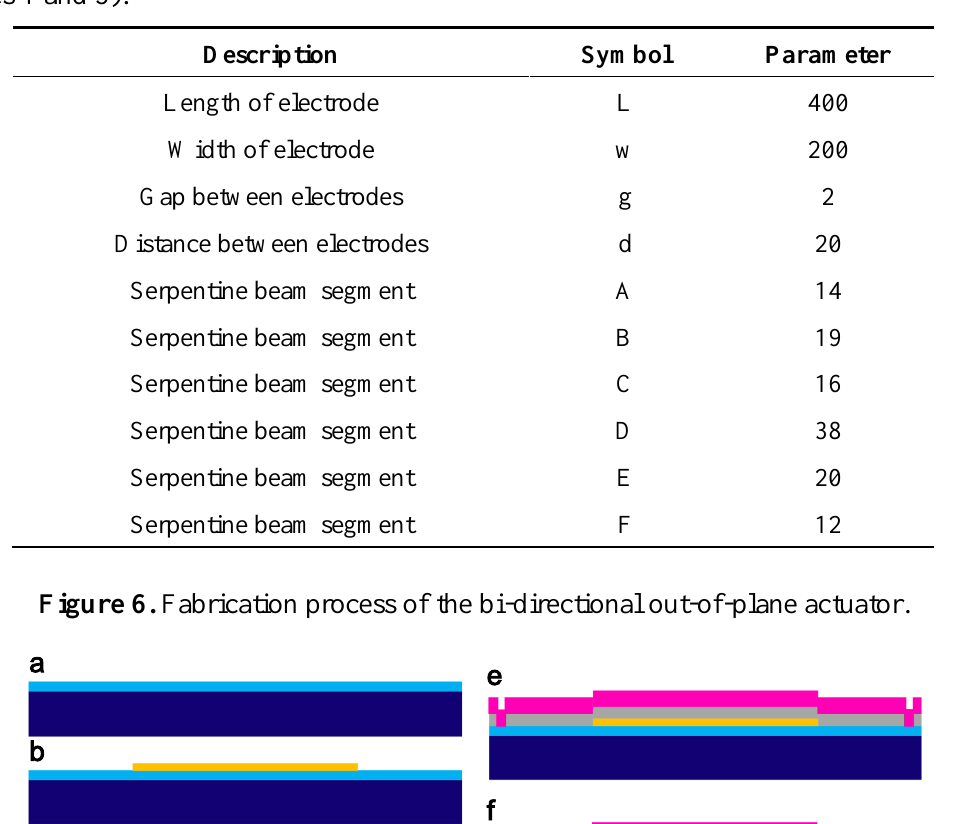
Table 1. Out-of-plane actuator parameters for fabrication (in µm, symbols are illustrated in Figures 1 and 5).